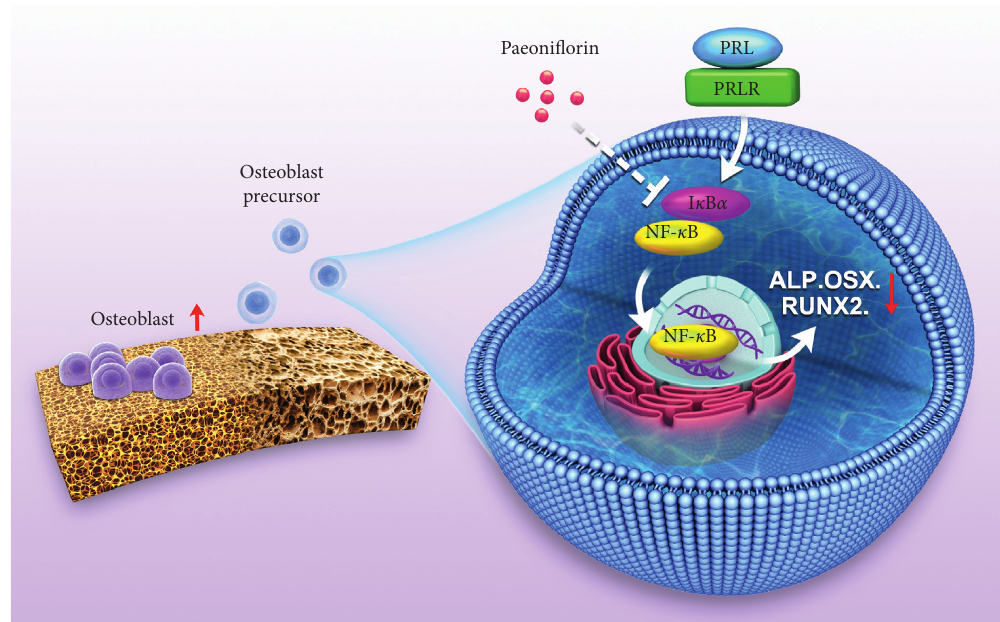
Scheme 1: PF ameliorated HPRL-induced osteoblastogenesis inhibition by promoting osteoblast differentiation by inhibiting nuclear factor kappa B (NF- κ B) activity. PRL, prolactin; PRLR, prolactin receptor; ALP, alkaline phosphatase; OSX, Osterix; RUNX2, runt-related transcription factor 2; I κ B- α , inhibitor of kappa B